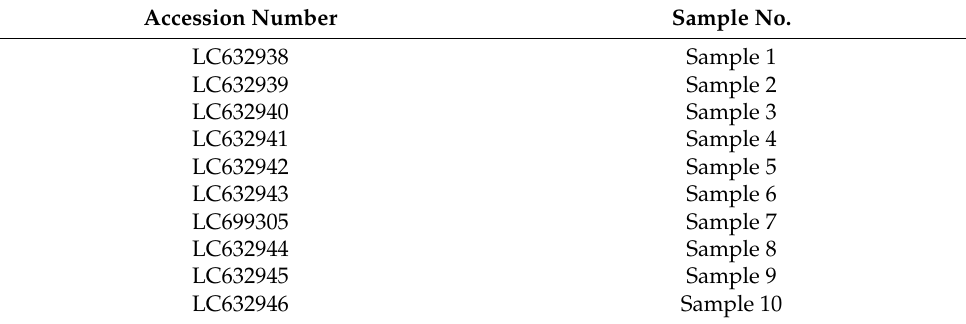
Table 2. Accession numbers for ten novel